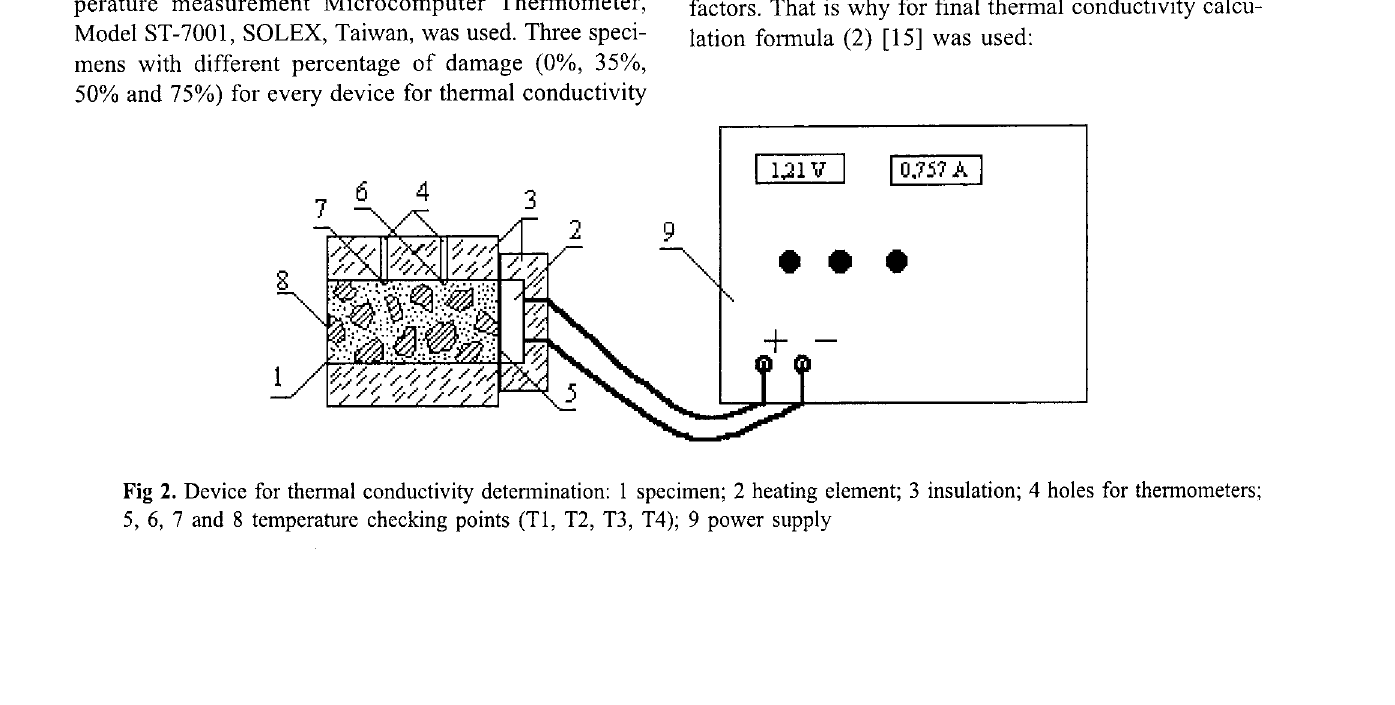
Fig 2. Device for thennal conductivity detennination: 1 specimen; 2 heating element; 3 insulation; 4 holes for thermometers; 5, 6, 7 and 8 temperature checking points (Tl, T2, T3, T4); 9 power